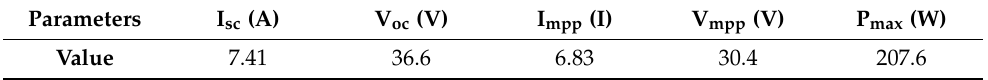
Figure 2. Photo of the commercial PV module used in the practical experiment (the solar cell cover with a board at the bottom right corner of the module shows the shadowed solar cell). Table 2. Electrical parameters of the PV module used in temperature